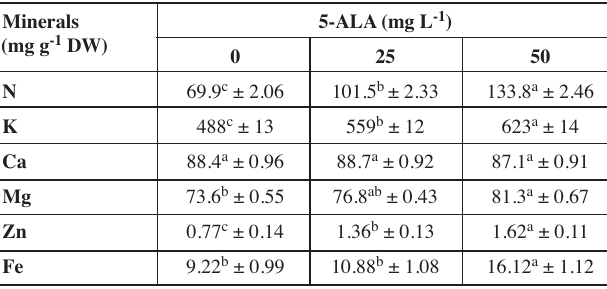
Fig. 5: The effects of different 5-ALA treatments on antioxidative activity of Portulaca oleracea extract measured by DPPH assay. Means marked by the same letter are not significantly different according to DMRT at P ≤0.05. Error bars represent standard deviation. followed by malic acid (5.52 mg g -1 root DM), oxalic acid (5.10